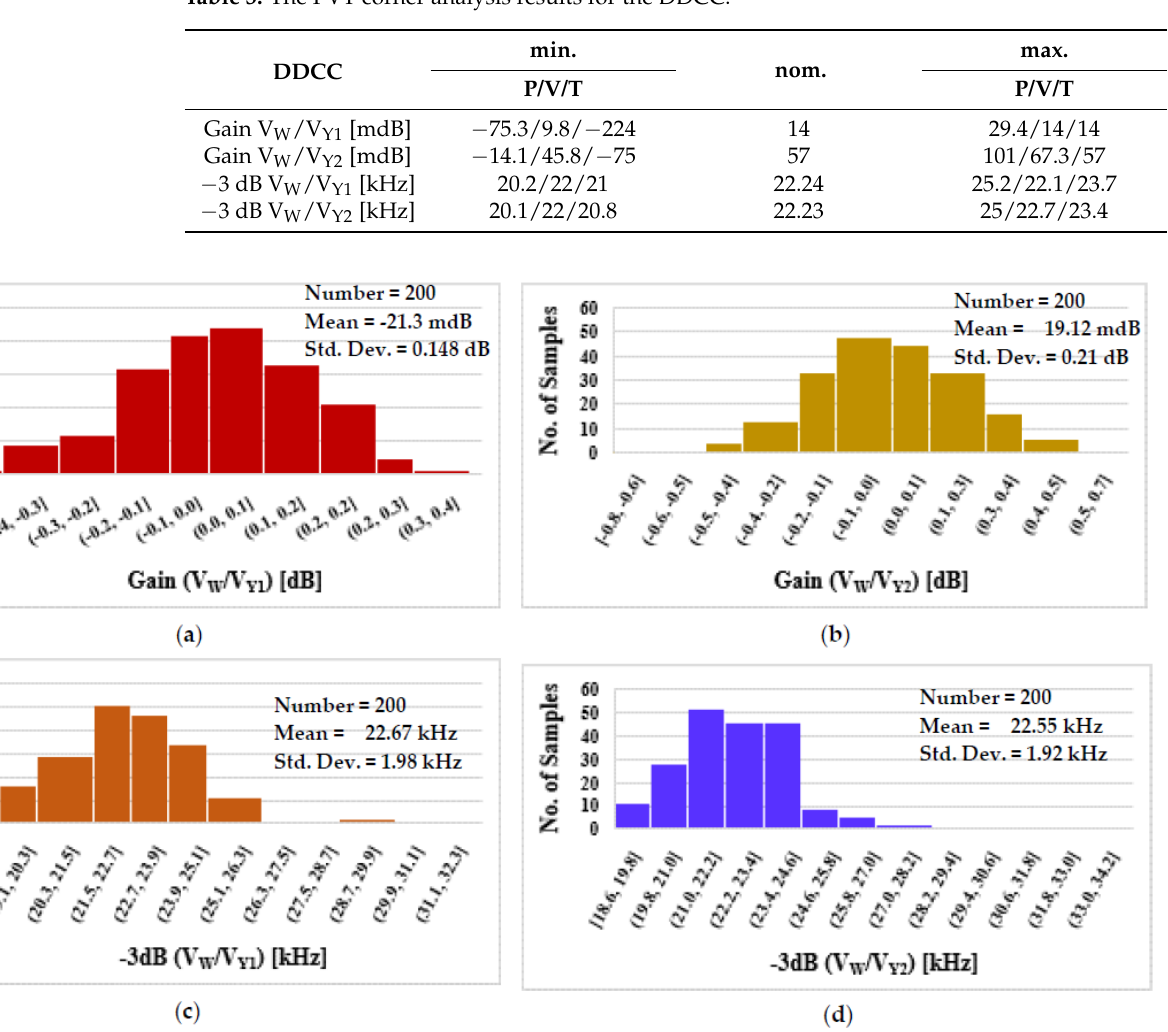
Figure 11. The TA histogram of the gain ( a ) and phase error ( b ). The process, voltage, temperature (PVT) corners analysis was also provided on the proposed DDTA. The MOS transistor corners were slow-slow, slow-fast, fast-slow, and fast-fast, the voltage supply corners were (V DD − V SS ) ± 10%, and the temperature corners were − 20 °C and 70 °C. Tables 3 and 4 show the results of the minimum, nominal, and maximum values of the gain, − 3 dB BW for the DDCC, and gain and phase error for the TA. The impact of the PVT corners in all cases is acceptable .